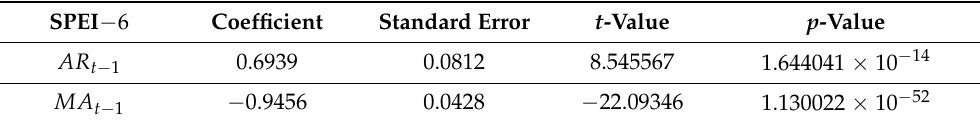
Table 10. SPEI-6 ARIMA (1,1,1) for